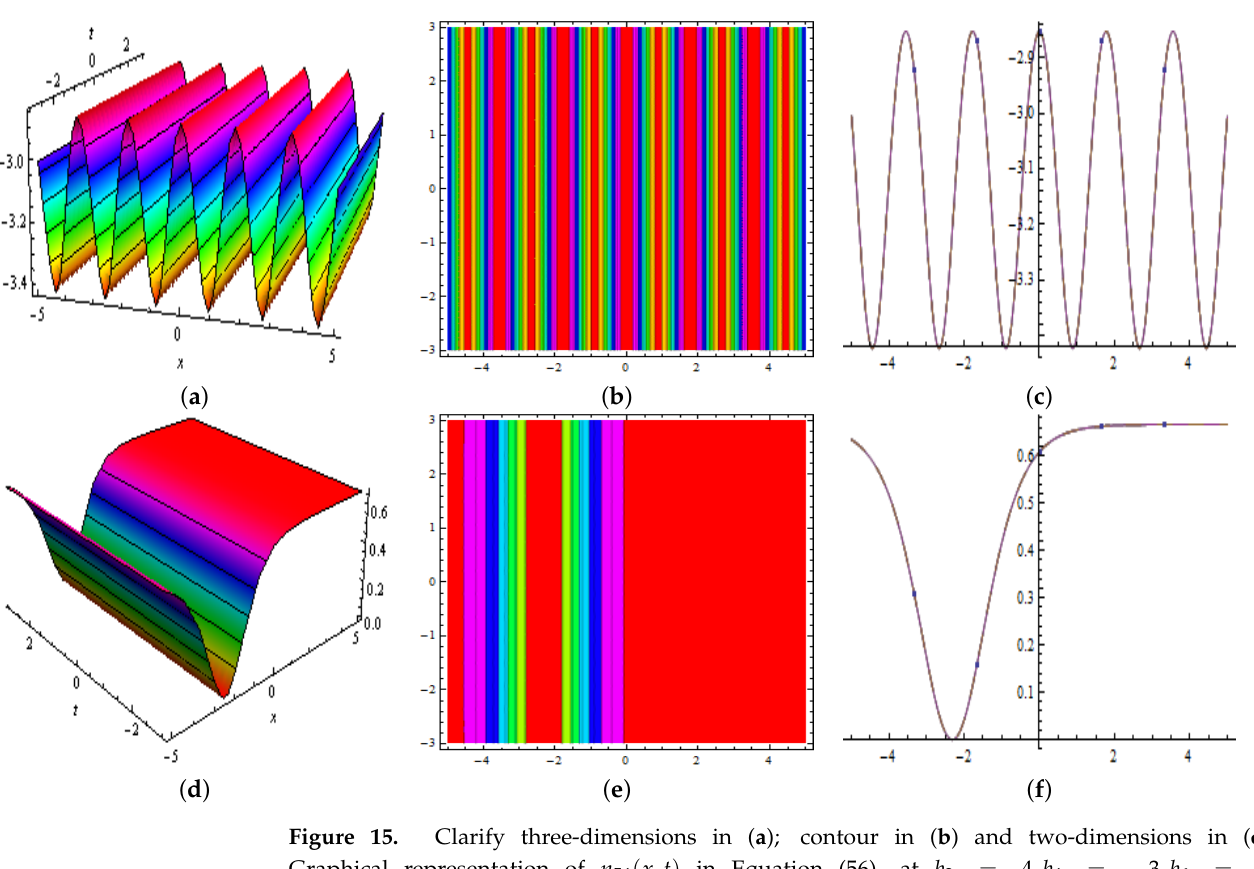
Figure 15. Clarify three-dimensions in ( a ); contour in ( b ) and two-dimensions in ( c ), Graphical representation of n 54 ( x , t ) in Equation (56), at b 2 = 4, b 4 = − 3, b 6 = 3, z 1 = − 1.5, z 2 = 2.5, p = 1, q = − 1, u 0 = 1, α = 0.6,